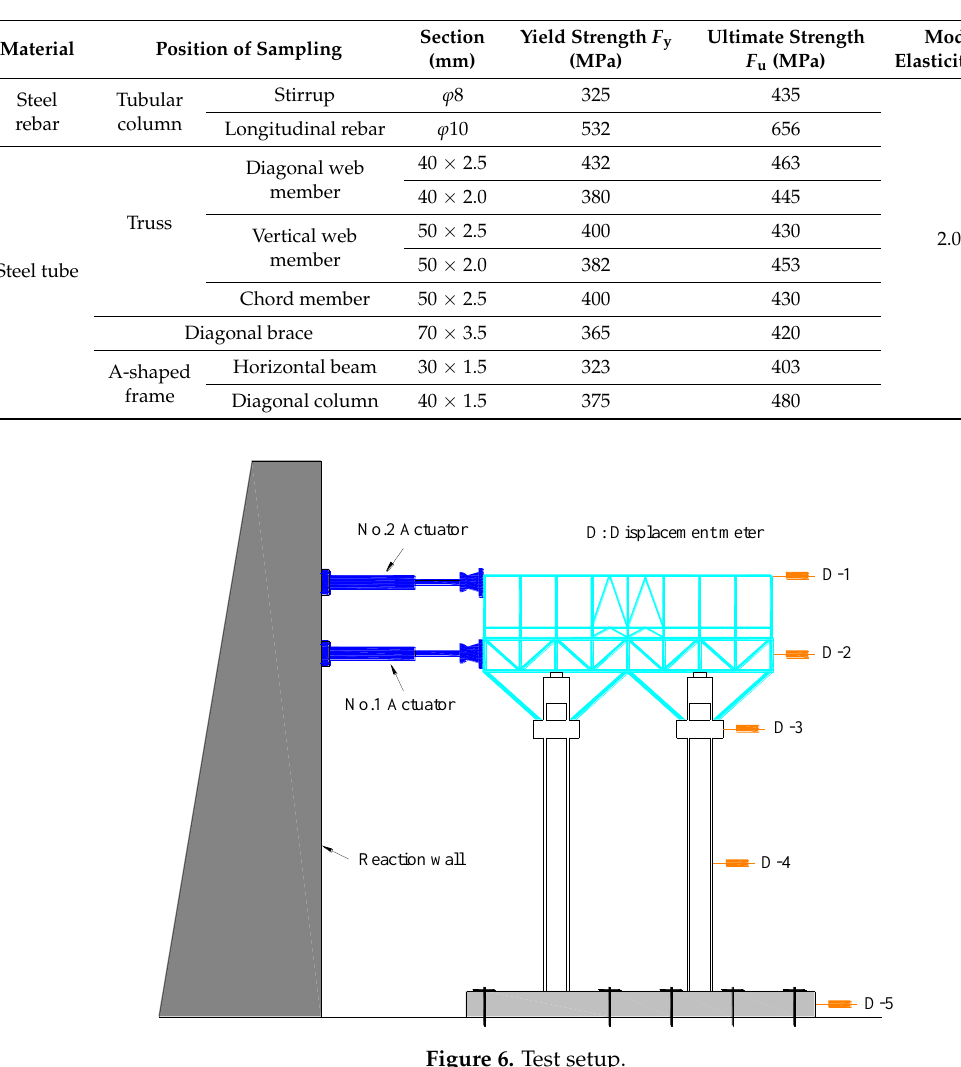
Table 2. Material properties of steels used in the test specimen.